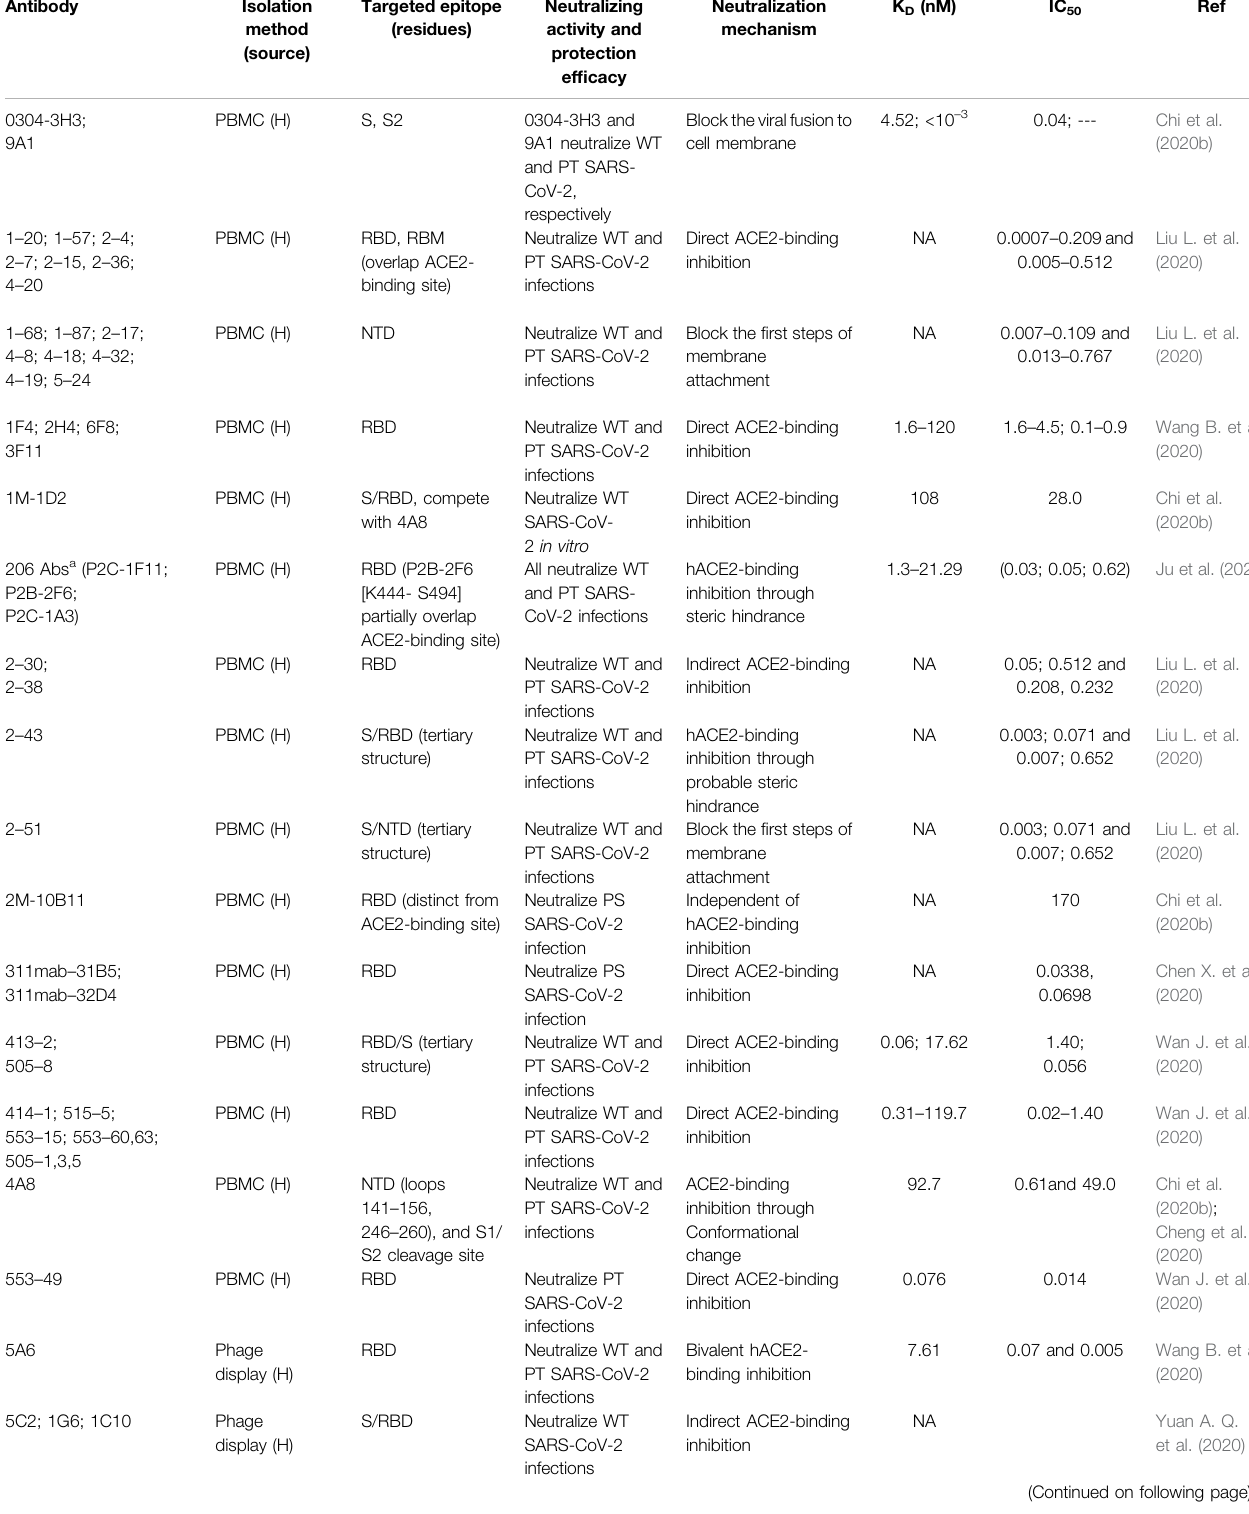
TABLE 3 | Reported SARS-CoV-2-speci fi c